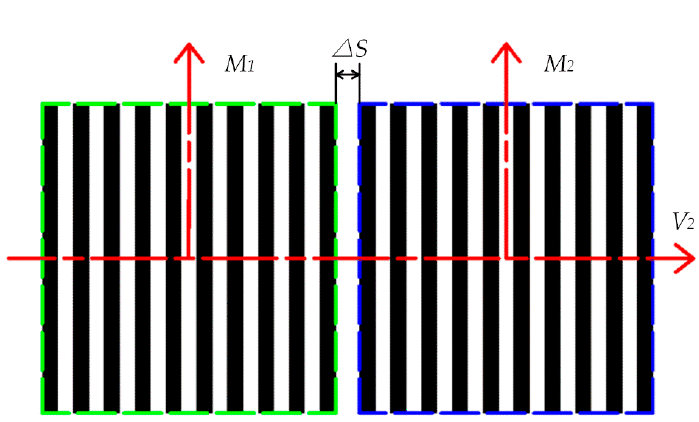
Figure 2. Ideal splicing scheme for two CCD images in the process of precision alignment.